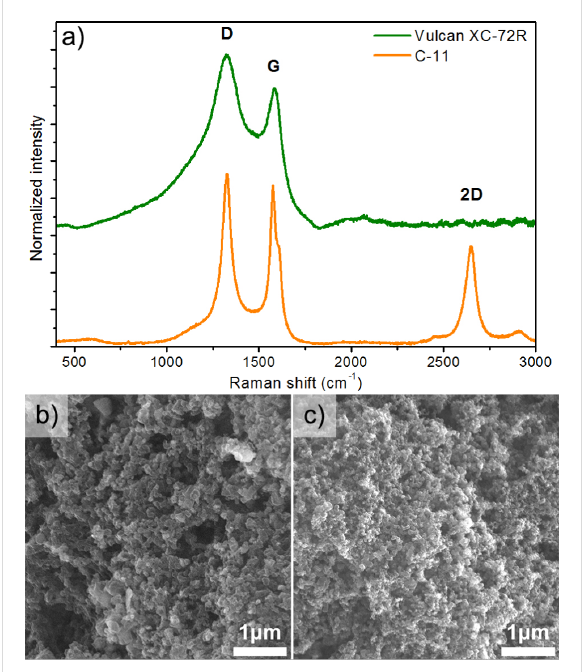
Figure 1: (a) Raman spectra of carbon supports, commercial Vulcan XC-72R, and synthesized C-11, (b) SEM images of the synthesized carbon material C-11, and (c) SEM image of the Vulcan XC-72R refer- ence material.